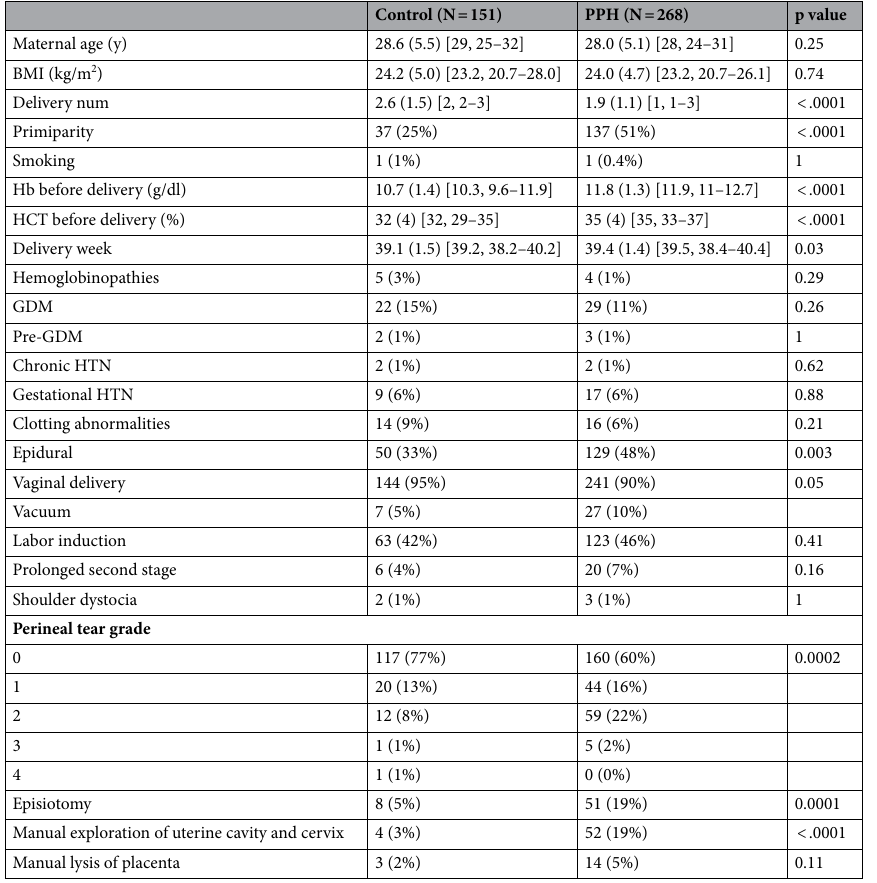
Table 1. Patient demographics, pregnancy, and delivery characteristics. Values are presented as mean (SD) (median, [interquartile range]) or number (percent). BMI body mass index, Hb hemoglobin, HCT hematocrit.